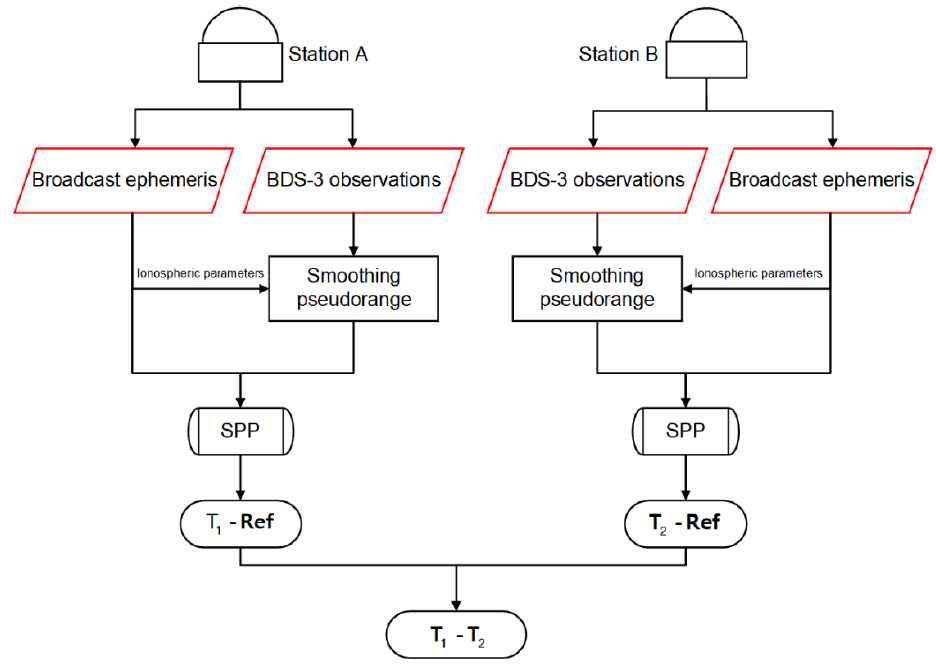
Figure 1. Principle of phase-smoothed pseudorange SF SPP time transfer based on BDGIM.